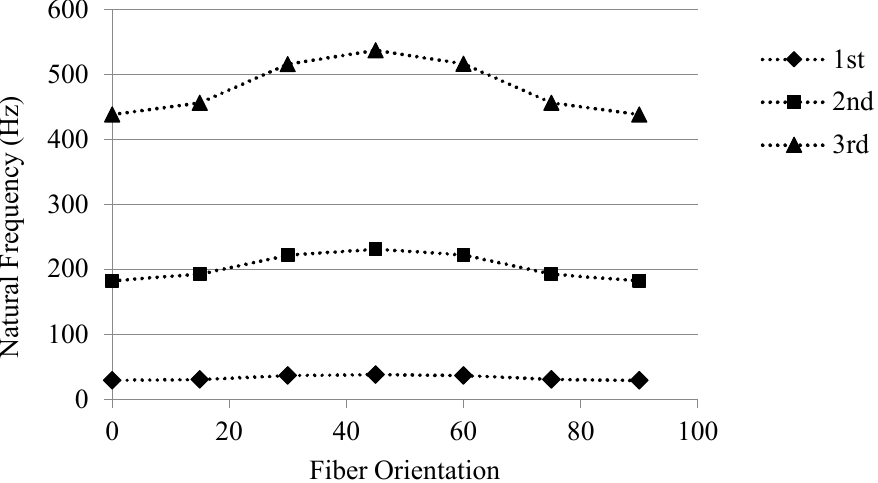
Figure 5. Variation of the first three natural frequencies for a composite beam with glass–epoxy composite ply angle using a five-element DFE model with M zz = 20 N.m and P = 10 N.